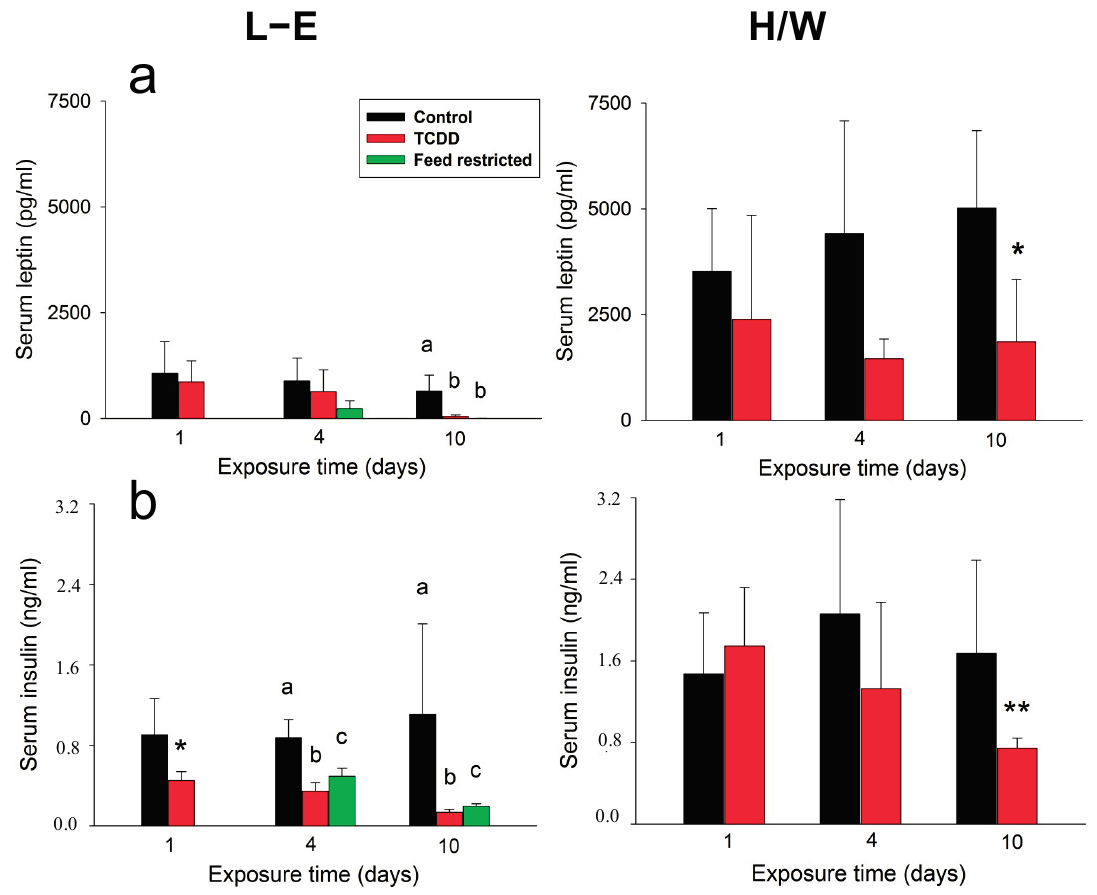
Figure 2. The effect of TCDD or feed restriction on ( a ) serum leptin and ( b ) serum insulin concentrations in L-E ( left panel) and H/W rats ( right panel) as a function of time (mean ± SD). The conditions are as in Figure